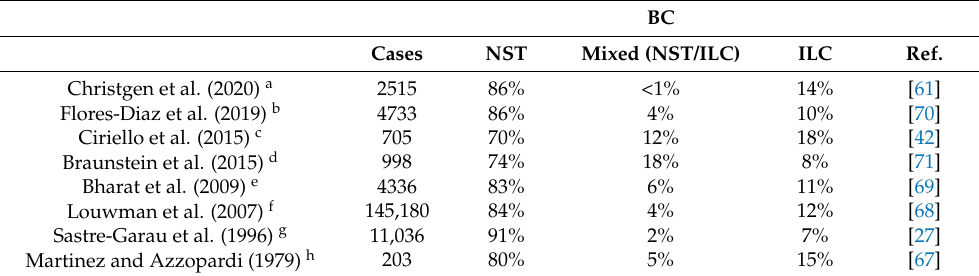
Table A1. Proportion of mixed BC (NST/ILC).